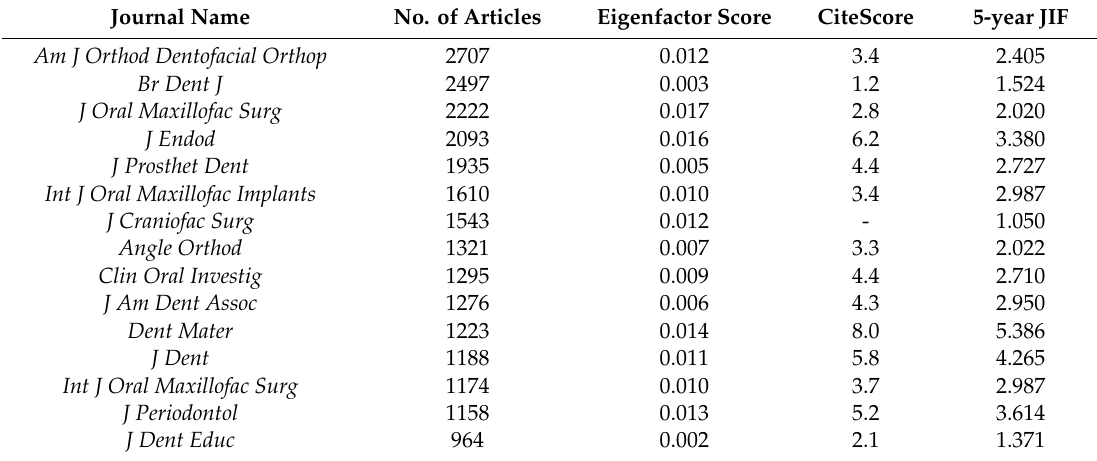
Figure 1. Sequence chart, Global Dental Publications and impact factor characteristics of most relevant sources with Journal Citation Reports (JCR) 2009 to 2019. Note: Non-JCR most relevant sources are not included. Table 3. Impact factor metrics of the most relevant sources having JCR.